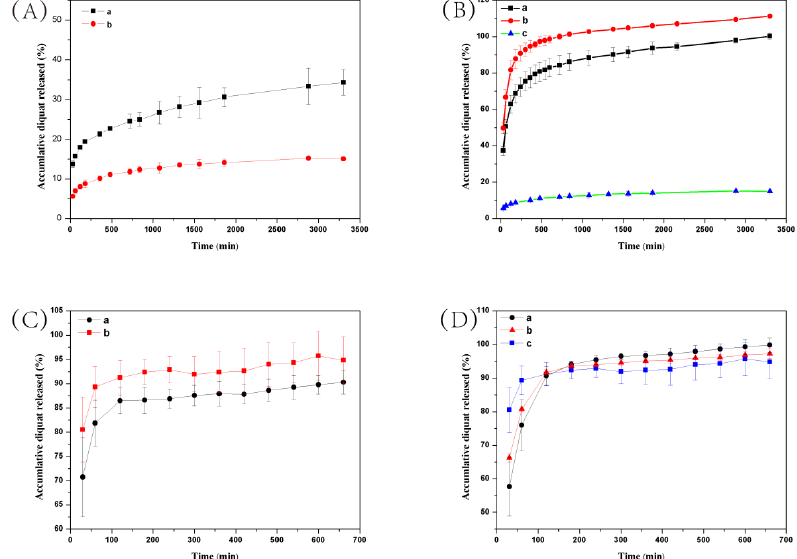
Figure 6. Release profiles of DQ from DQ@MSN-SO 3 ( A , B ) and DQ aqueous solution ( C , D ) at different pH values ( A and C , a: pH = 3, b: pH = 7) and ionic strengths ( B and D , a: 0.1M Na 2 SO 3 , b: 0.2M Na 2 SO 3 , c: water). Error bars correspond to standard errors of triplicate measurements.